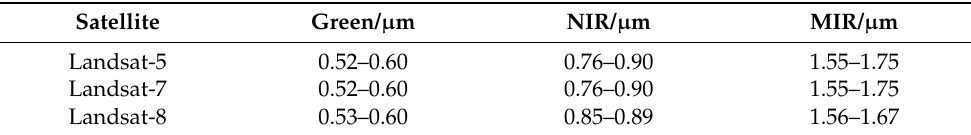
Table 2. Wavelength ranges of the band used in this study.